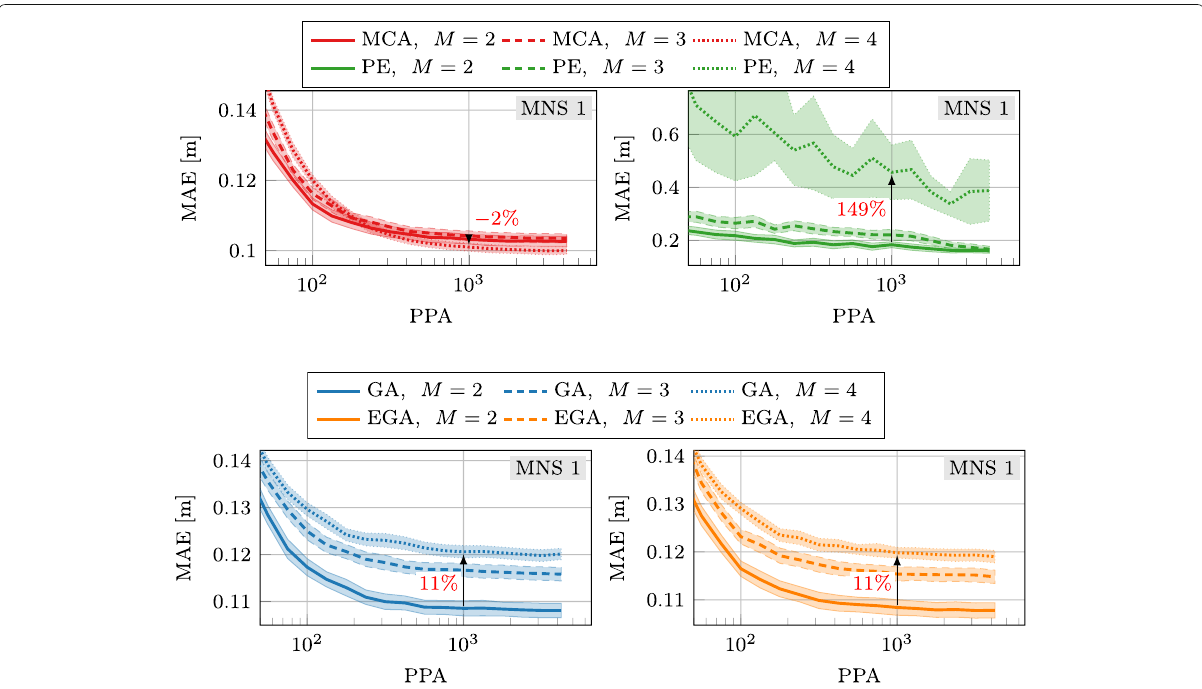
Fig. 8 Localization error as a function of the number of PPA for different numbers of agents to be tracked for MNS 1